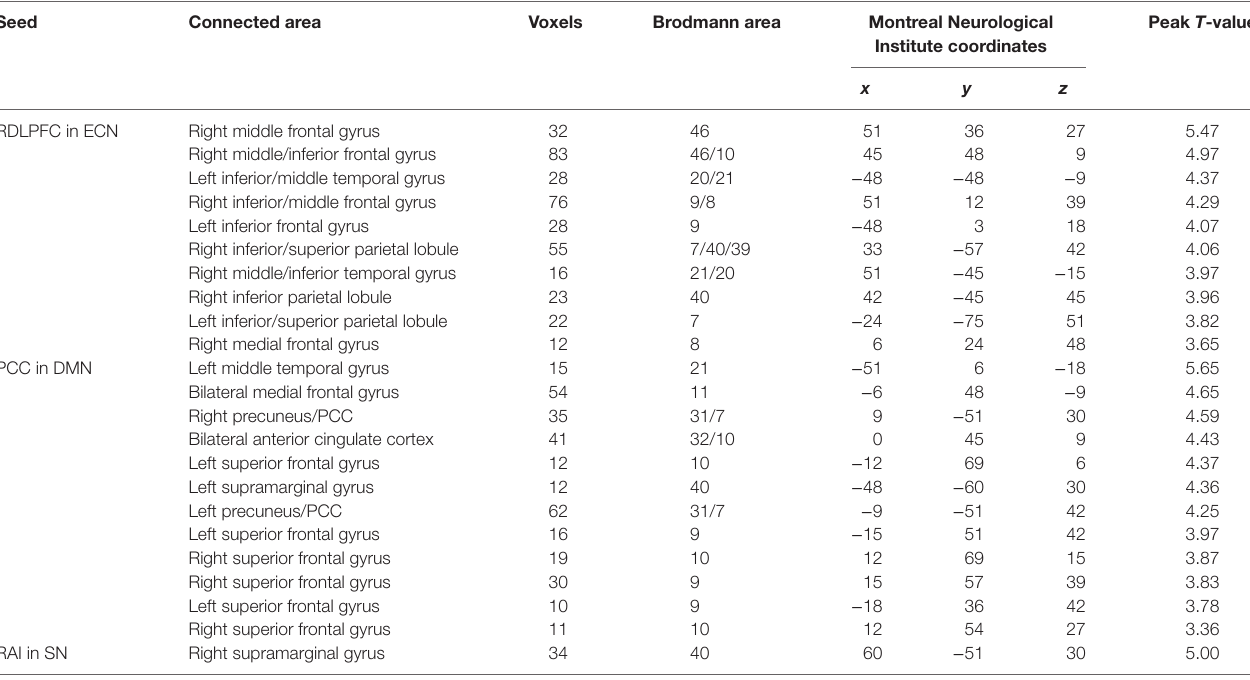
Peak T -value institute coordinates x y z